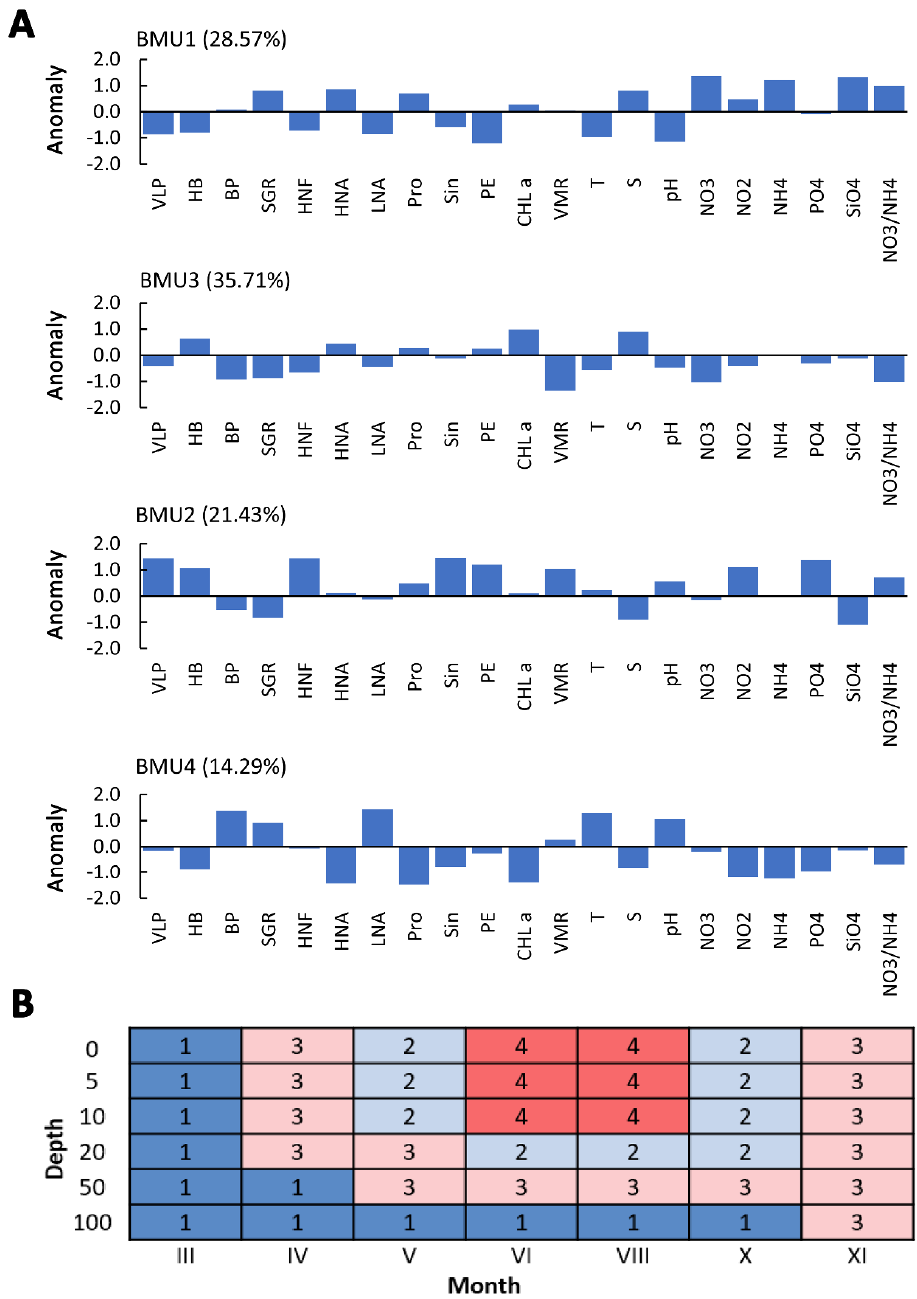
Figure 2. ( A ) Bar plot representations of biotic and abiotic parameters for NG best-matching units and the relative frequency appearance for each unit. Values are standardized as z-scores; ( B ) water column distribution of NG best-matching units (labelled by number and di ff erentiated by colour).